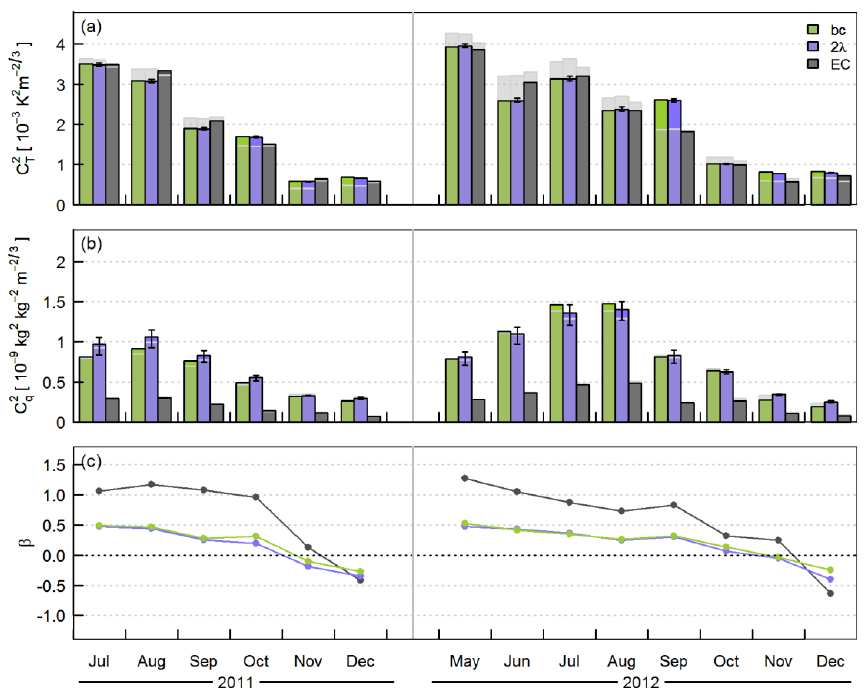
Figure 9. Mean daytime (incoming shortwave radiation K ↓ > 5Wm − 2 ) (a, b) structure parameters and (c) Bowen ratio calculated according to Eq. (9) for each month calculated for the BLS–MWS system (bichromatic-correlation and two-wavelength approaches) and eddy covari- ance data scaled to match the BLS–MWS height. For the two-wavelength results r Tq _2 λ =± 0.8; error bars in (a) and (b) indicate the effect of assuming r Tq values of ± 0.5 and ± 1.0. Light grey bars (a, b) indicate means calculated when both C 2 (bc, 2 λ and EC) are available.